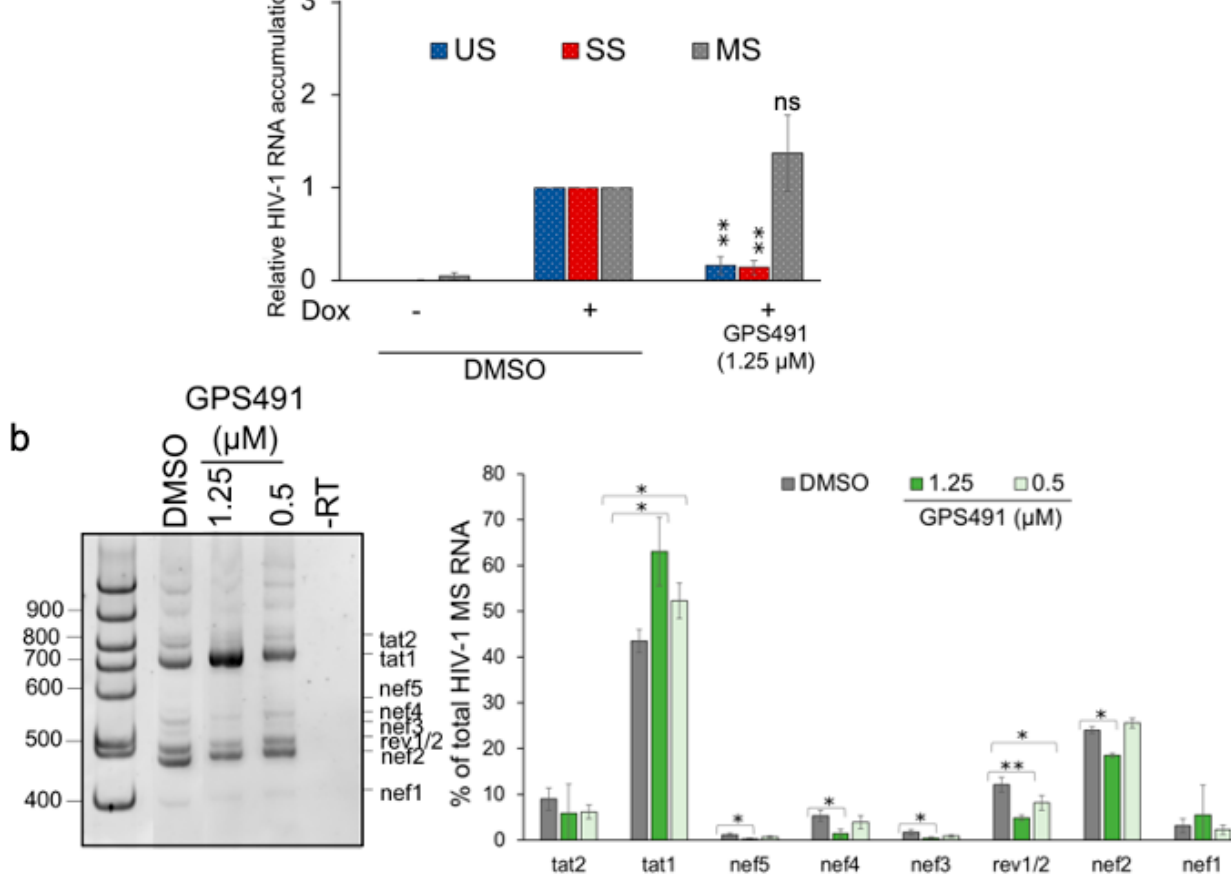
Figure 2. Effects of GPS491 on HIV-1 RNA accumulation and processing. HeLa rtTA HIV ∆ mls cells were treated with DMSO or varying concentrations of GPS491 +/ − doxycycline (Dox) for 24 h. Cells were then harvested, total RNA was extracted, and cDNA was generated. Samples were subsequently analyzed ( a ) by RT-qPCR to measure levels of HIV-1 US, SS, and MS RNA levels or ( b ) by RT-PCR to measure levels of different MS RNA isoforms. Shown is a representative gel and summary quantitation of results from n > 3 independent assays. Data are indicated as mean ± SD, * p ≤ 0.05, ** p ≤ 0.01, ns—not